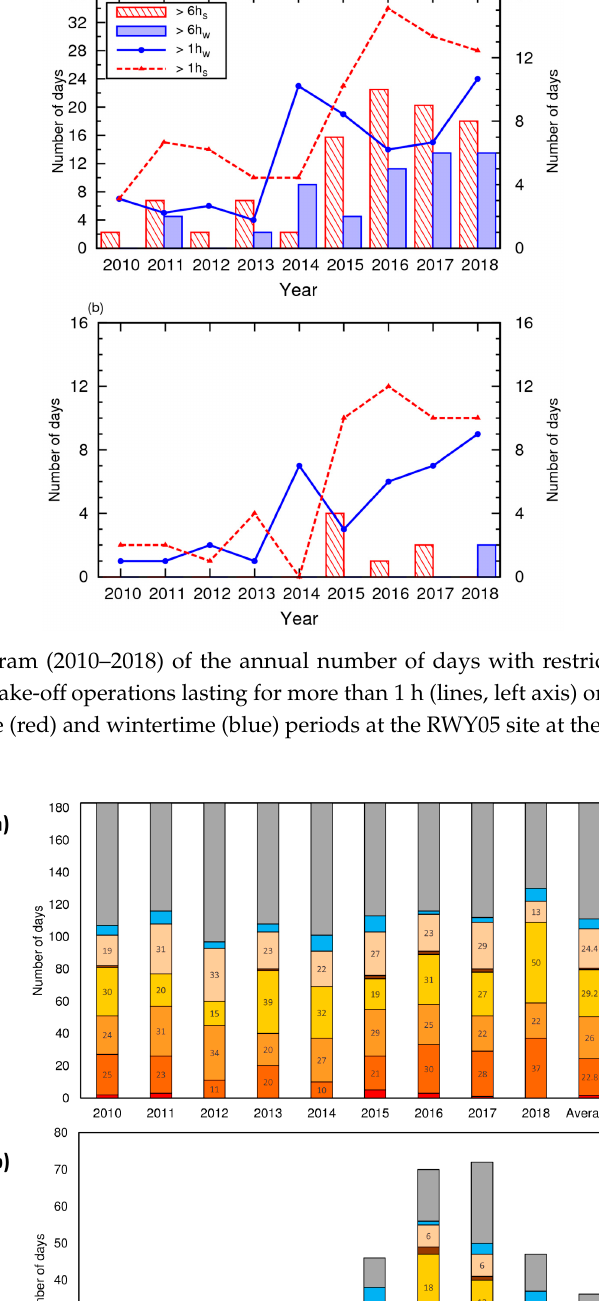
Figure 8. ( a ) Time evolution of the number of days of the WTs. The WTs responsible for the most adverse wind conditions at MIA are represented separately, while the remaining WTs are represented as “other”. The average number of days of these WTs is also plotted (average bar). The number of days for WT14, WT11, WT1 and WT2 are also indicated. ( b ) Similar to ( a ), but for the days with restriction episodes lasting more than 1 h.